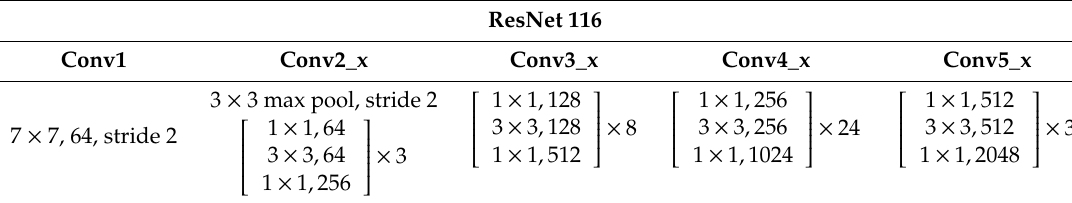
Table 4. The network structure of